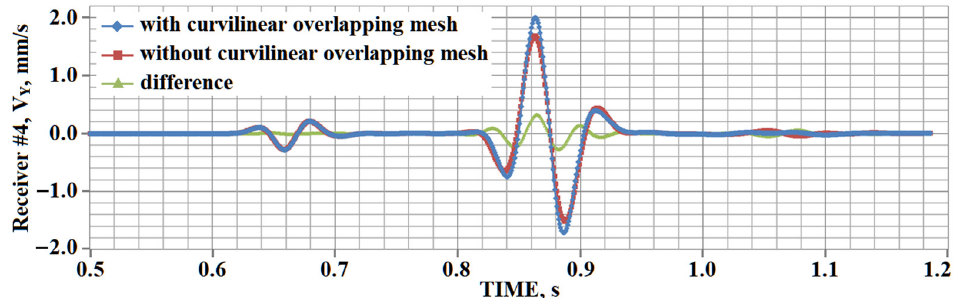
Figure 14. Receiver #4, dependencies of Y-component of velocity on time. The data on the plots in Figures 12–20 are registered by the receivers marked by red color in Figure 8 and correspond to vertical lines on the seismograms in Figures 9–11.